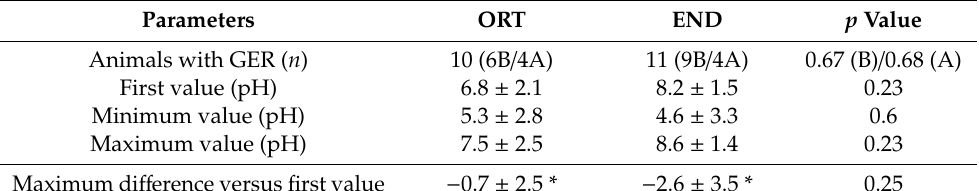
Table 2. Episodes of gastroesophageal reflux and details of the pH measurements in dogs undergoing orthopaedic surgery (ORT) or endoscopic examination (END). Data are reported as mean ± standard deviation (SD). * Statistically significant di ff erence ( p <